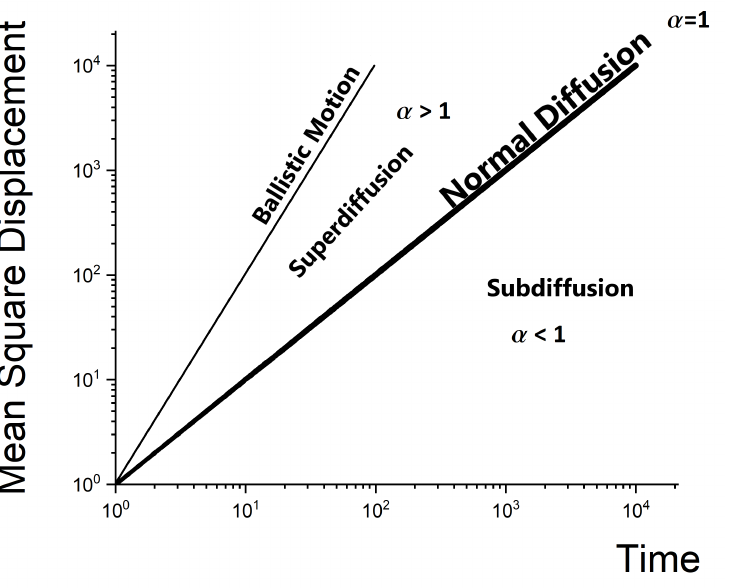
Figure 1. Anomalous diffusion regimes as characterized by Equation (2), i.e., power-law scaling of the mean squared displacement (MSD) with